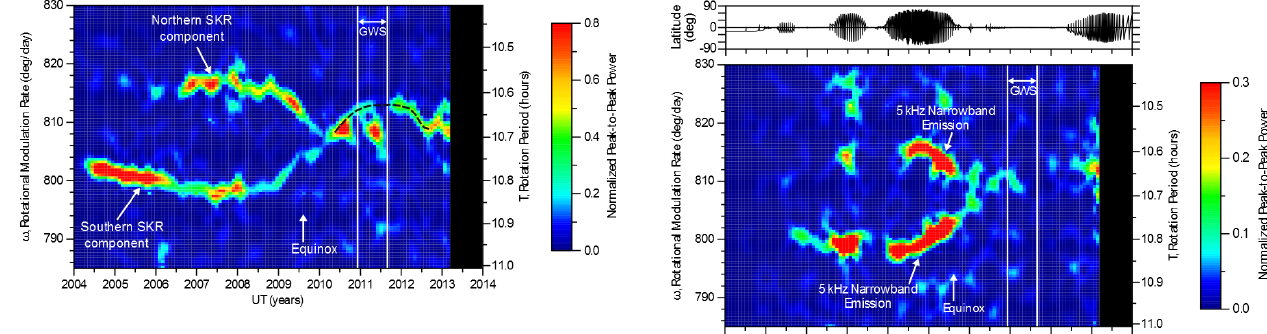
Figure 1. Normalized peak-to-peak power of Saturn kilometric ra- diation modulation as a function of time from 2004 until early 2013. The ordinate shows the angular velocity (rotation rate) in degrees per Earth day (left side) and the corresponding rotation period in hours (right side). The normalized peak-to-peak power is given by the color bar, and the signal processing was done as in Gurnett et al. (2009). The duration of the Great White Spot (GWS) event is indicated. There are two periods related to SKR from different hemispheres until shortly after equinox, but there is mainly one pe- riod until 2013 (black dashed line) except for a few months in early 2011.